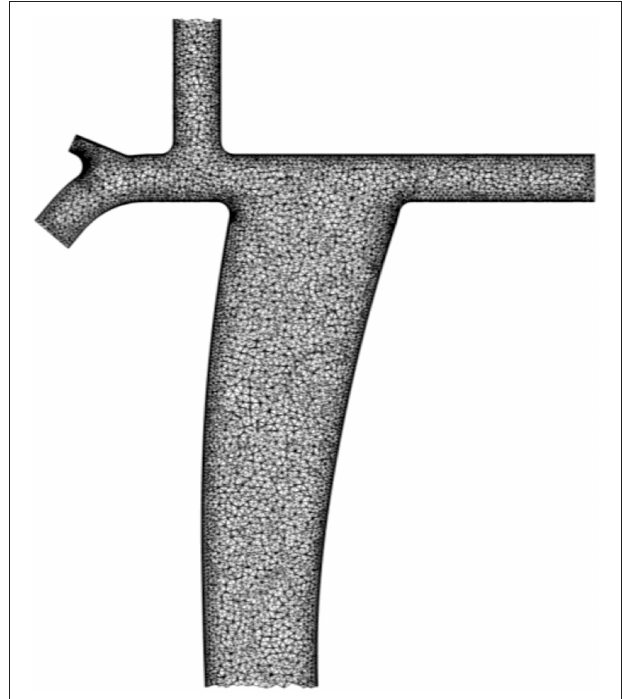
FIGURE 2 | Computational domain of the conventional Fontan configuration meshed by a five-layers thick prism carpet mesh lining the walls that surrounds an unstructured tetrahedral